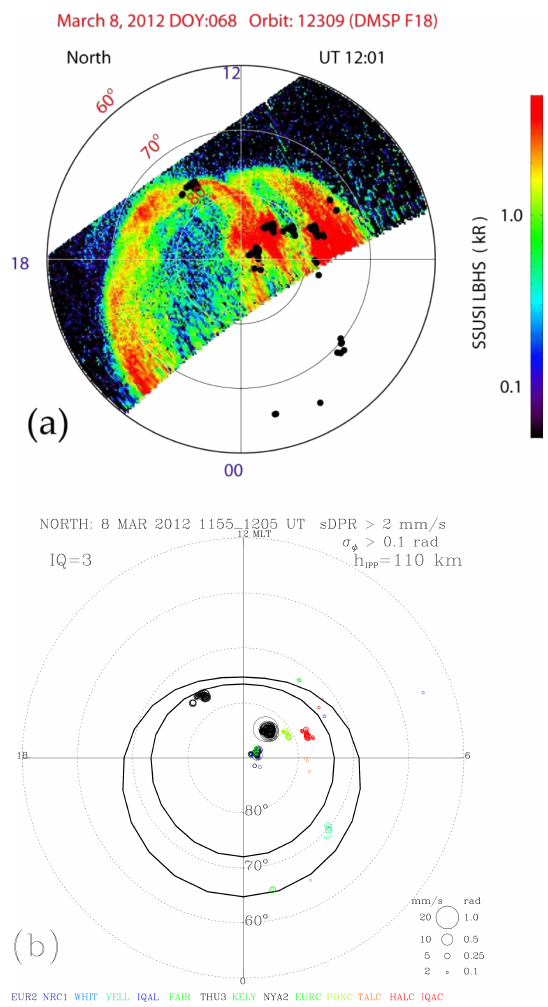
Figure 9. (a) SSUSI (DMSP F18) auroral image scans mapped as a function of AACGM latitude and MLT. Superposed (black dots) are IPPs where scintillation σ (cid:56) >0.1rad or sDPR>2mms − 1 . (b) The IPPs are shown as circles scaled proportionally to σ (cid:56) and sDPR